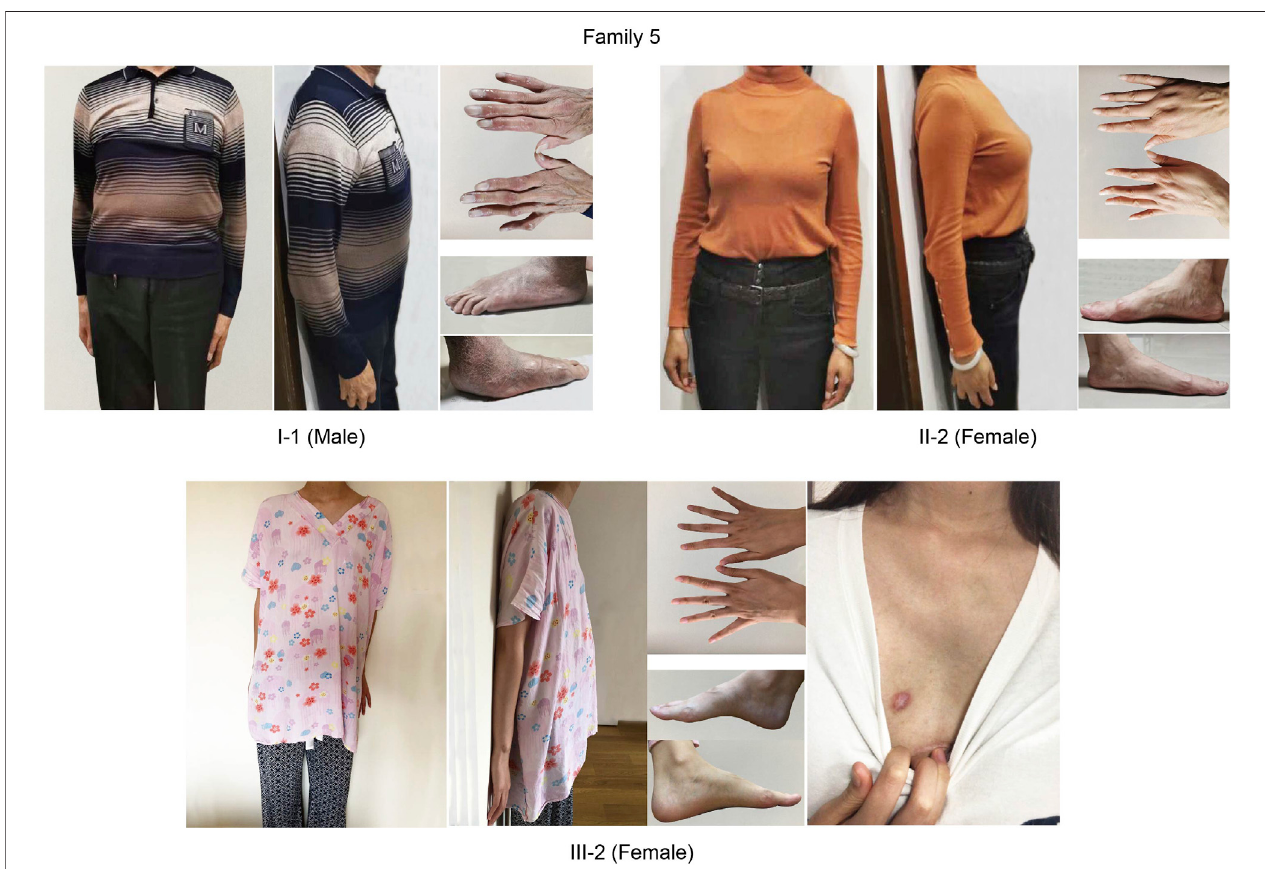
FIGURE 5 | Clinical features of MFS patients in Family fi ve who chose to do IVF with PGT-M. All three patients posted cardiac surgery. They all had a clinical manifestation of arachnodactyly and pectus excavatum/pectus carinatum. I-1 and III-2 had scoliosis. I-1 and II-2 have fl atfeet.